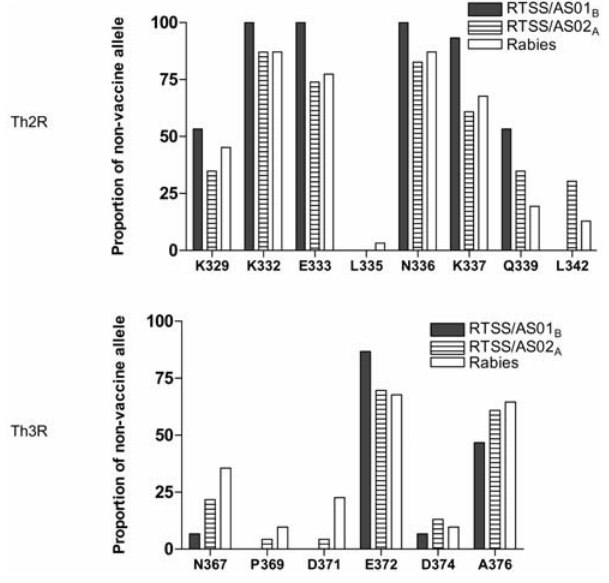
Figure 4. Distribution of csp non-vaccine type alleles during period of active detection of infection. Percentage non-vaccine type alleles for the polymorphic amino acids sites in the Th2R and Th3R regions of the RTS,S vaccine and control groups during the ADI